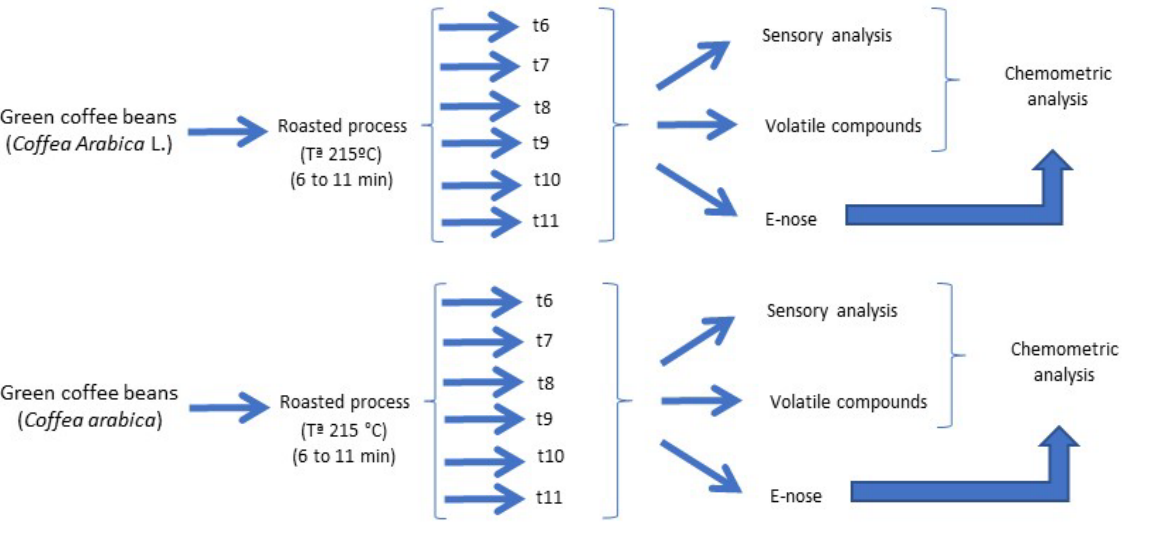
Figure 1. Diagram of the experiment.